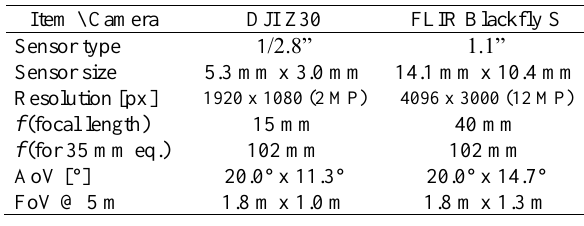
Table 1. Cameras specifications during simulation. Where: Angle of view (AoV) and field of view (FoV). Both focal lengths were 5 m.